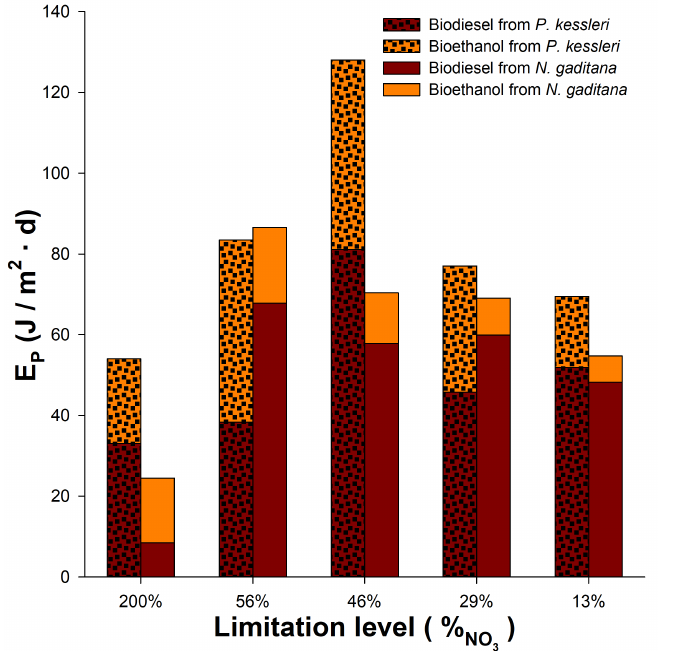
Figure 4. Potentially recoverable energy values for N. gaditana and P. kessleri obtained in continuous nitrogen-limited